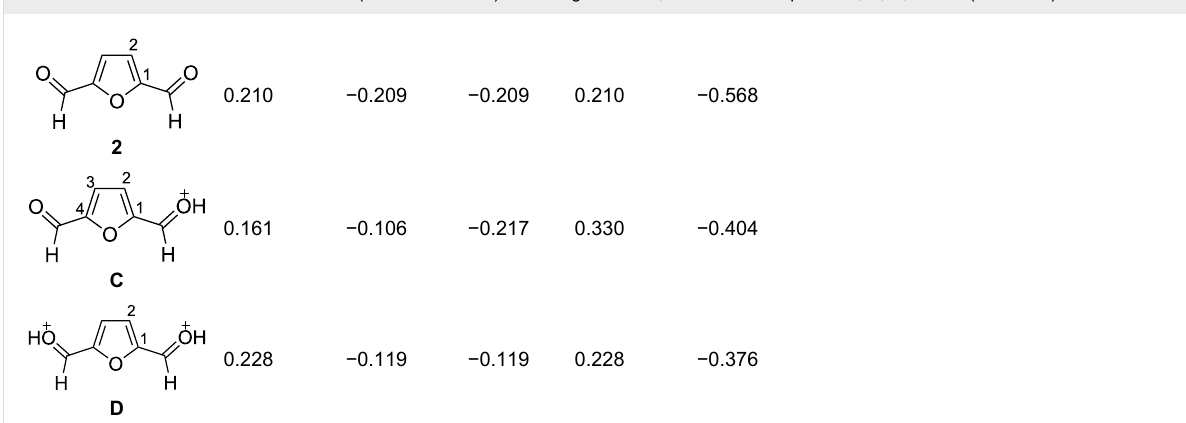
Table 1: Selected electronic characteristics (DFT calculations) of starting furans 1a , 2 and cationic species A , B , C , and D . (continued)